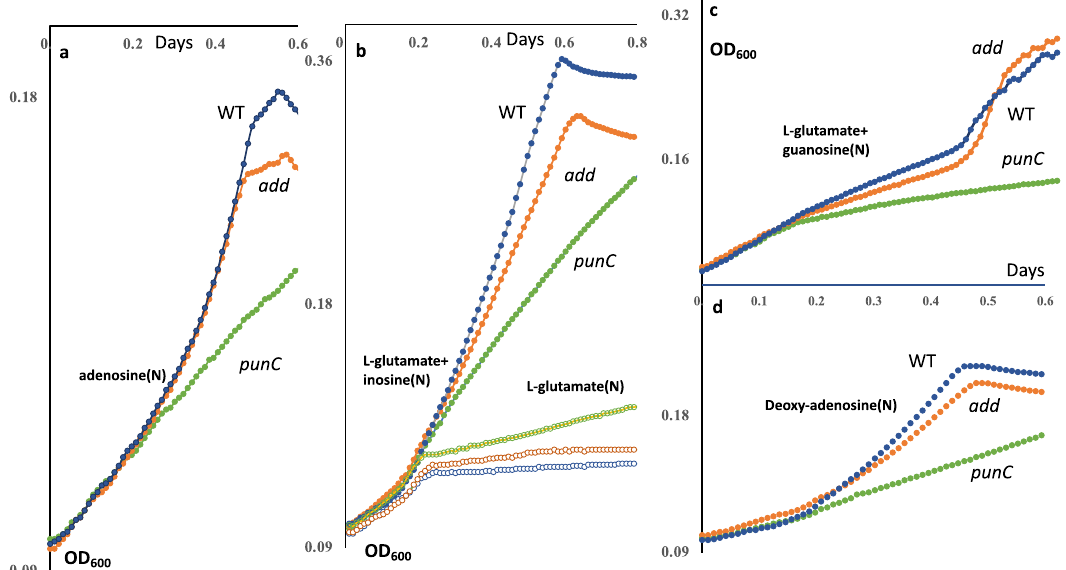
Fig. 6 Growth phenotypes of the add and punC knockout strains in M9 medium with 0.4% glycerol as the carbon source and various nitrogen sources as follows. a 2.5 mM adenosine as the sole nitrogen source, b 5 mM L-glutamate and inosine, or 5 mM L-glutamate (empty circles with strains indicated with corresponding colour), c 5 mM L-glutamate and guanosine and d 5 mM 2-deoxyadenosine as the sole nitrogen source. The growth of the punC (green circles) and add (orange line, circles) deletion strains were compared to the wild-type E. coli BW25113 strain (dark blue line, circles). these purposes, we used Biolog plates 11C and 12. Each of these plates contained four different concentrations of 24 different antibiotics. The punC mutant (kanamycin resistant) and WT strains showed the same resistance for all of the included anti- biotics except paromomycin, 2,4-diamino-6,7-diisopropyl-pter- idine, L-aspartic- β -hydroxamate and sulfonamides: sulfathiazole, sulfadiazine and sulfamethoxazole. The inhibition effect for kanamycin has not been detected for the wild-type strain. The other antibiotics tested at four different concentrations were